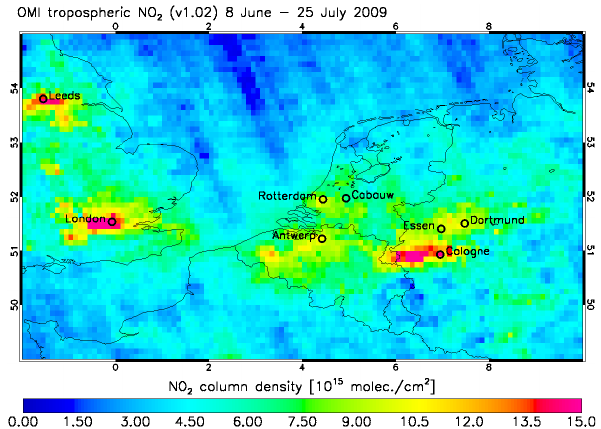
Fig. 2. Average tropospheric vertical NO 2 column during CINDI (between 8 June and 25 July 2009) as measured by OMI (DOMINO v1.02). The campaign site Cabauw is located almost in the middle of the Netherlands. Nearby pollution sources are the harbours of Rotterdam (40km) and Antwerp (Belgium, 90km) and the industrial Ruhr area in Germany (140 to